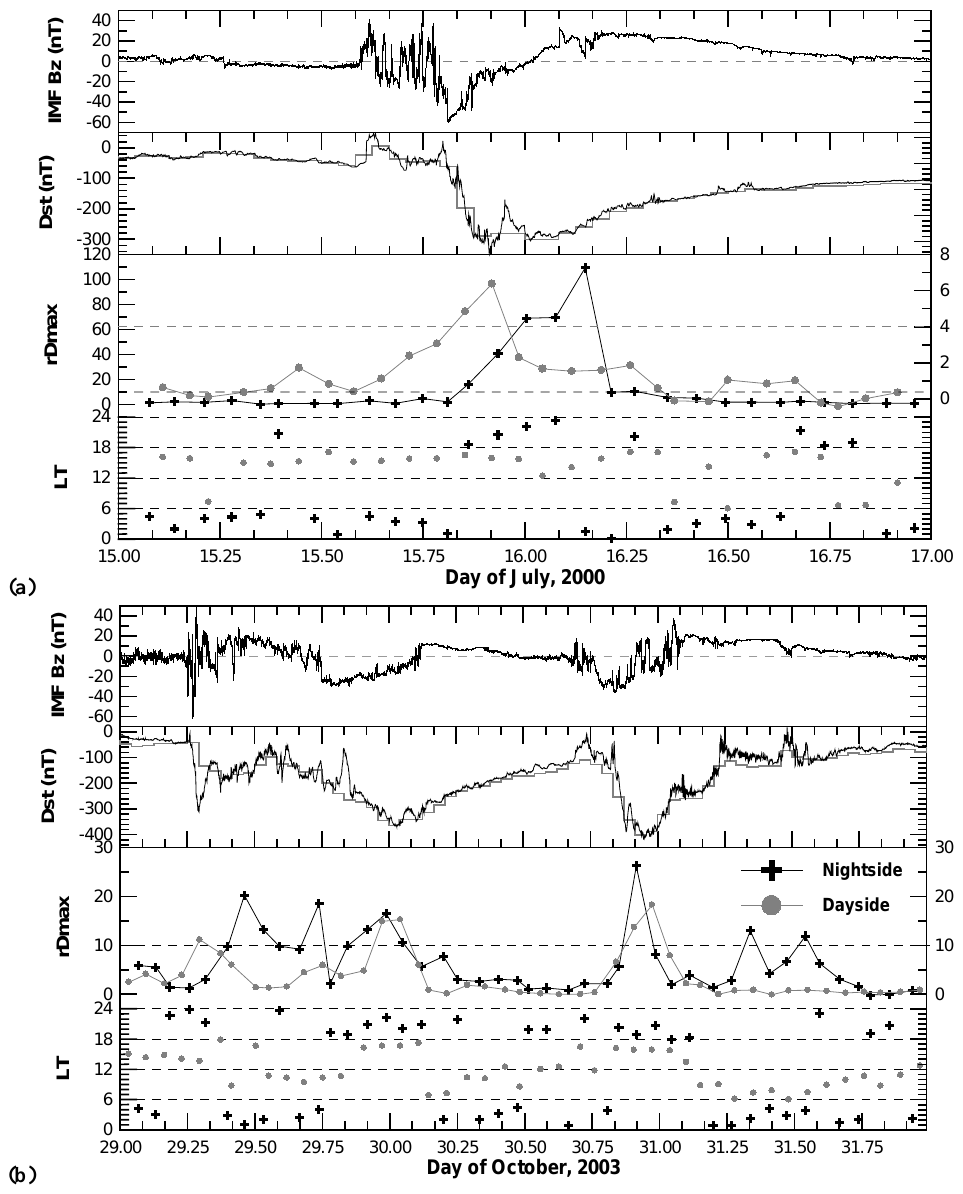
Fig. 5. Ion density enhancements during (a) Bastille storm on 15–16 July 2000 and (b) Halloween storms on 29–31 October 2003. The panels show from top to bottom: large variations of the IMF Bz measured by the ACE satellite; storm-time 1-h and 1-min D st -variation (gray histogram and black curve, respectively); maximal ion density enhancements rDmax detected at the low-latitude topside ionosphere by the ROCSAT-1/IPEI during dayside (gray circles, right axis) and nightside (black crosses, left axis) passes; and local time of the corresponding enhancements. Most prominent ion density enhancements both in sunlit and nightside ionosphere group around the maximum of magnetic